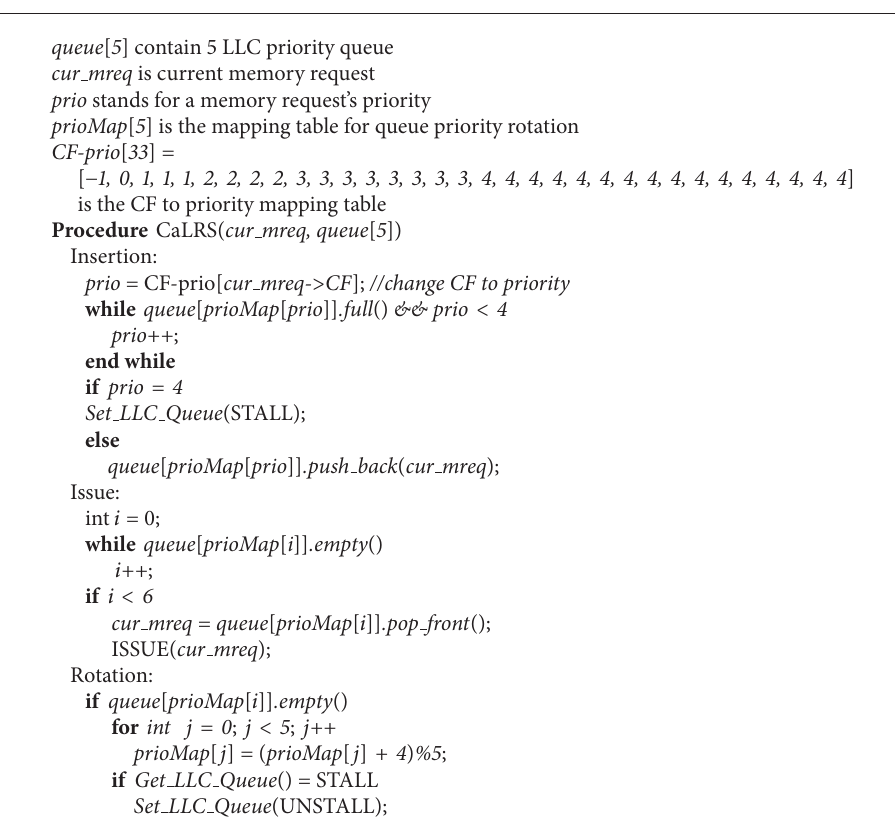
Algorithm 1: CaLRS scheduling algorithm.